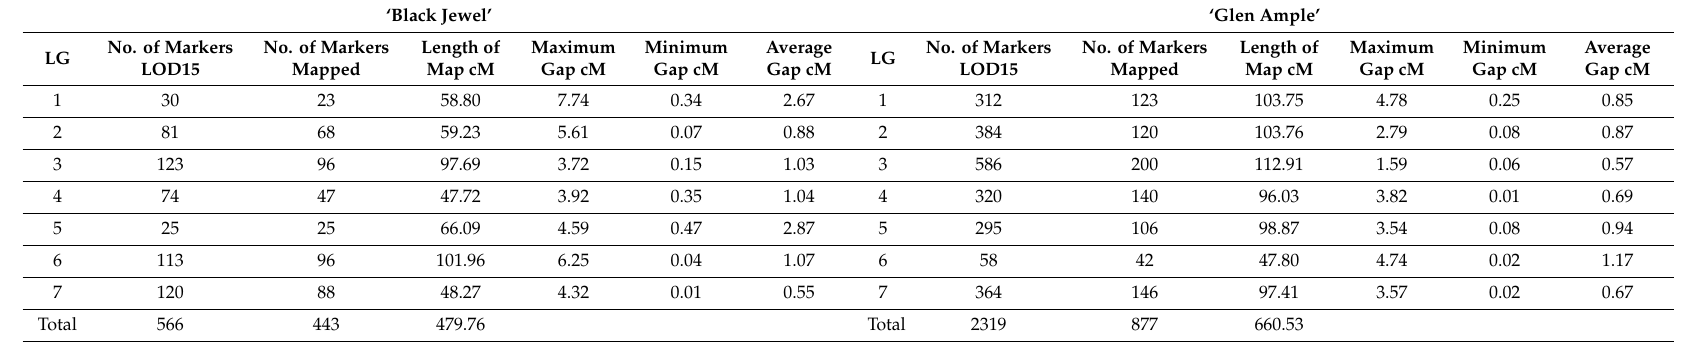
Table 2. Summary of the characteristics of the genetic maps of ‘Black Jewel’ and ‘Glen